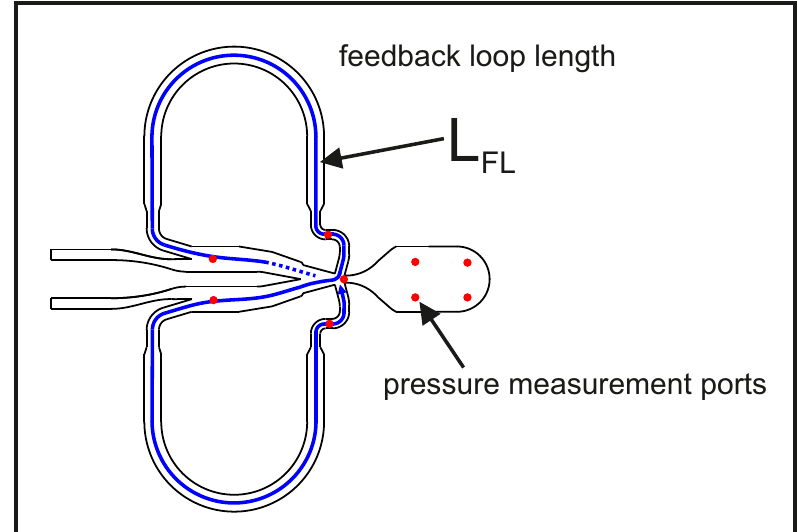
Figure 6. Feedback loop length and positions of pressure measurement